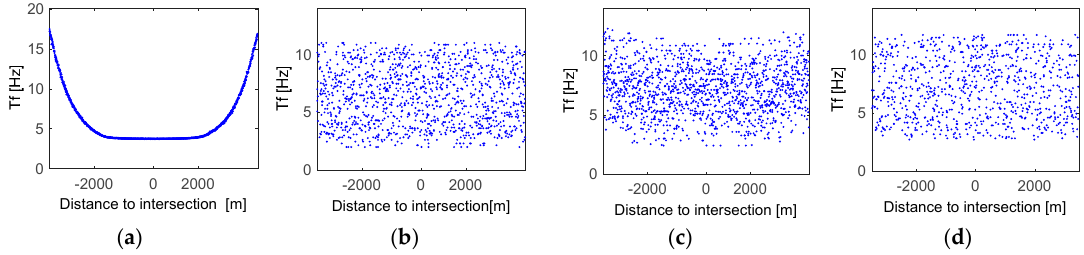
Figure 8. Snapshot of the transmission frequency used by each vehicle after 50 s of simulation time for a traffic density of 50 veh/km/lane. ( a ) A-DCC. ( b ) MINT. ( c ) INTERN. ( d ) COMPASS.